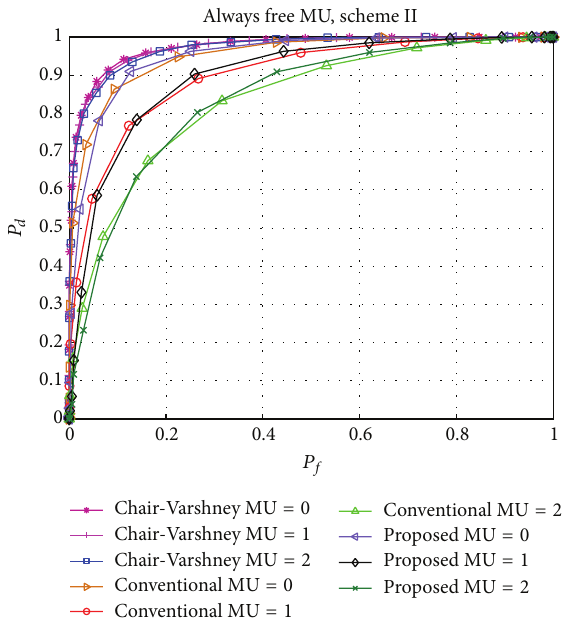
Figure 7: Performance comparison of the Chair-Varshney, conven- tional CSS, and proposed scheme II with always free (AF) MUs.